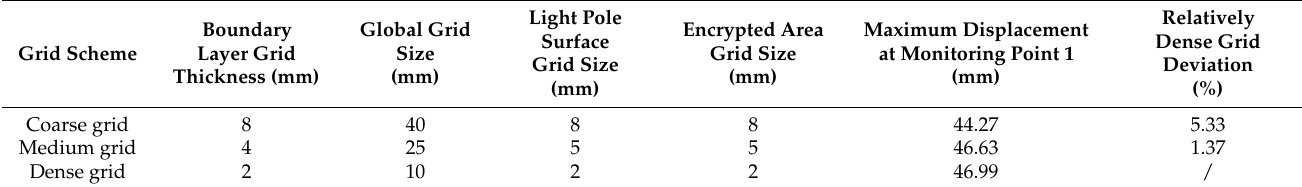
Table 3. Setting Parameters of Different Grid Schemes.